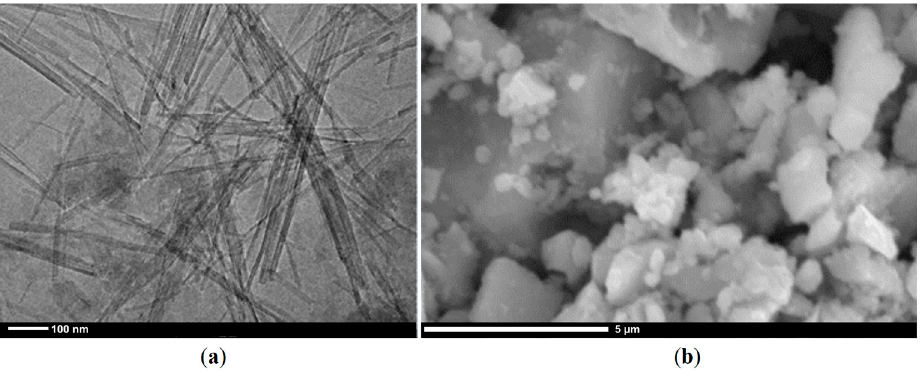
Figure 3. The microstructure of: ( a ) the sepiolite; ( b ) the SnO 2 layer.